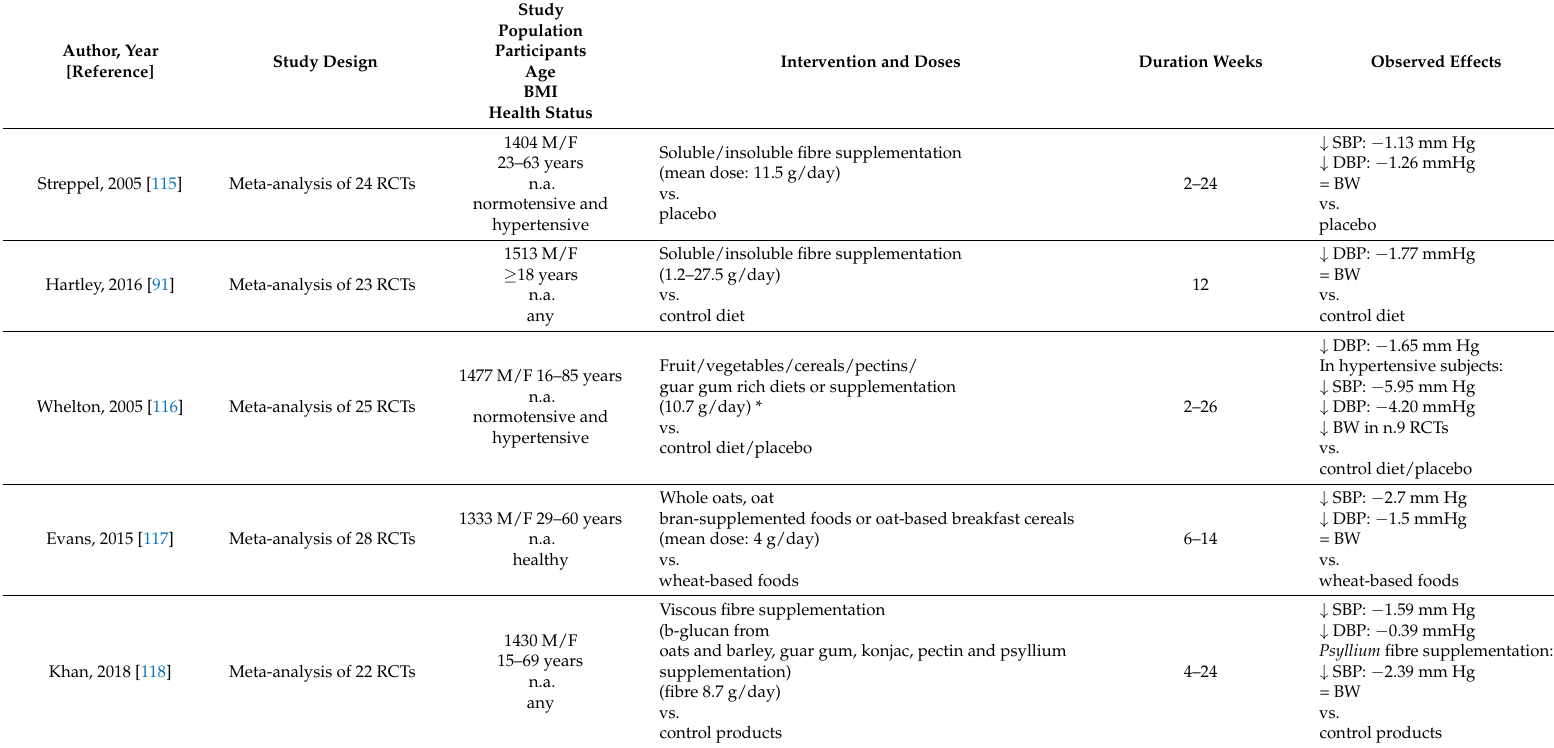
Table 6. Published meta-analyses of RCTs evaluating the effects of different types of fibre on blood